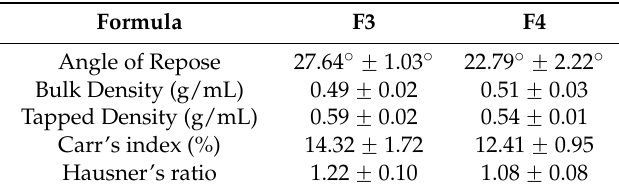
Table 10. Micromeritic Properties of OLM Loaded